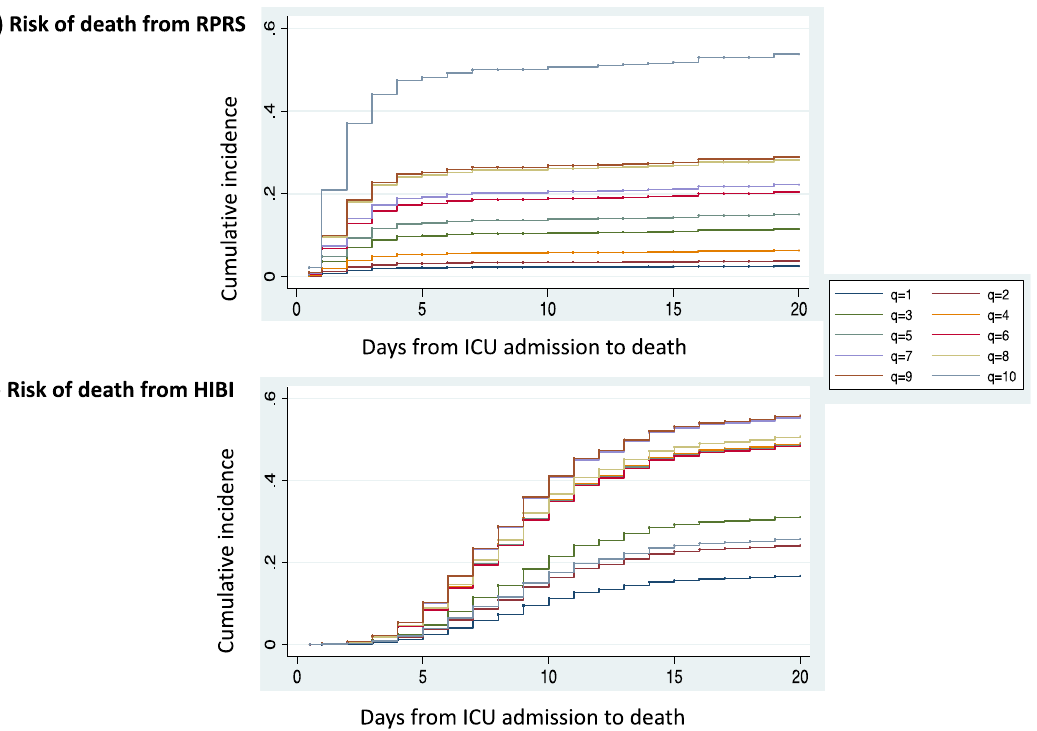
Figure 4. Cumulative incidence of each reason for death overtime in each CAHP score decile. ( a ) Risk of death from RPRS. ( b ) Risk of death from HIBI. CAHP Cardiac Arrest Hospital Prognosis, RPRS refractory post- resuscitation shock, HIBI hypoxic–ischaemic brain